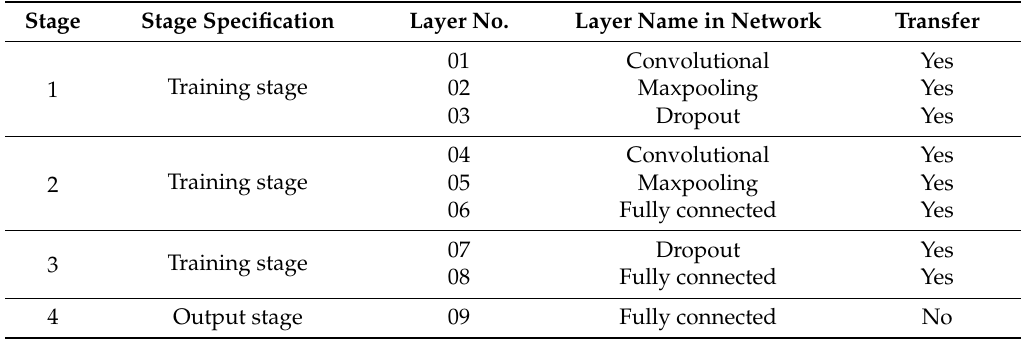
Table 1. Proposed architecture of the CNN for transfer specification for target network.